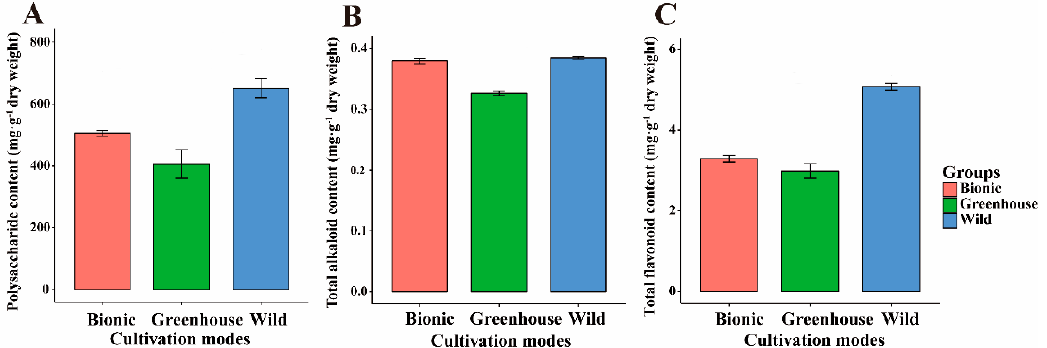
Figure 3. Main medicinal components variation in different cultivation modes. ( A ) Polysaccharide content variation in different cultivation modes. ( B ) Total alkaloid content variation in different cultivation modes. ( C ) Total flavonoid content variation in different cultivation modes.